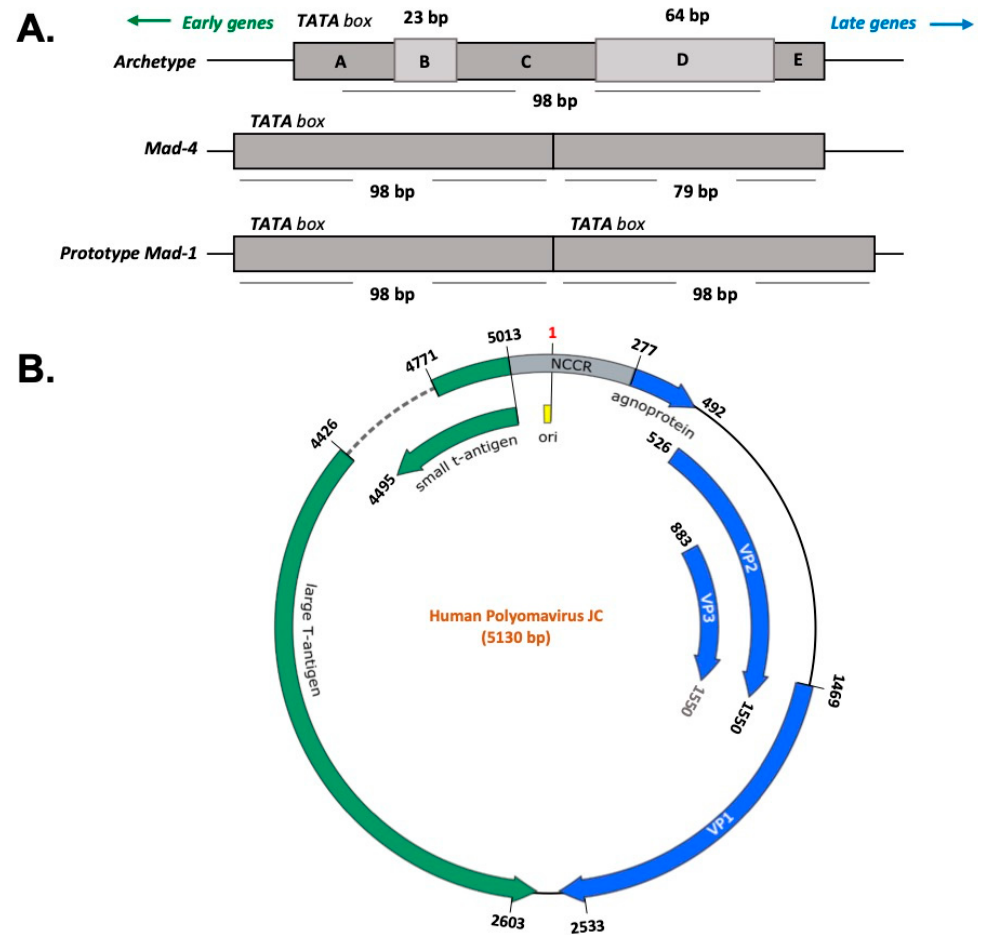
Figure 1. Polyomavirus JC genome. ( A ) The Non-Coding Control Region (NCCR) is the most variable region of the JCV genome and determines the viral strains. The Prototype Mad-1 strain is characterized by a sequence of 98 bp repeated in tandem . Mad-4 di ff erentiates from Mad-1 in the deletion of 19 base pairs in the second 98 bp repeat. The Archetype strain is composed of a single sequence of 98 bp with two insertions of 24 bp and 64 bp. ( B ) The NCCR is located between the two coding regions of the JCV genome: the early and the late regions. The early region encodes for the large T antigen (LTAg) and the small t antigen (stAg), whereas the late region contains the genes for the Agnoprotein and the capsid proteins VP-1, VP-2, and VP-3. The numbering of the nucleotide positions refers to the prototype Mad-1 strain (NCBI Reference Sequence: